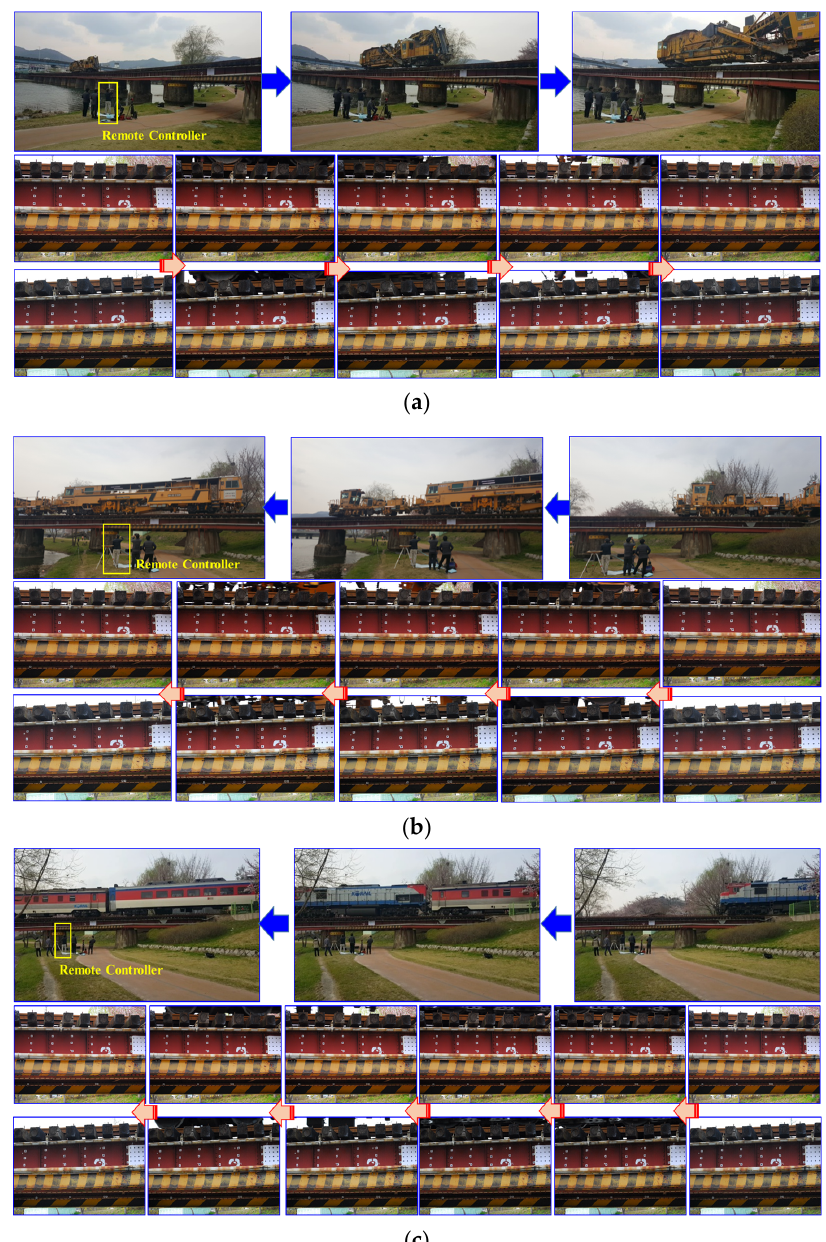
Figure 5. Train entry on the test span of the bridge. ( a ) The first maintenance train captured with five photos in seven seconds; ( b ) the second maintenance train captured with five photos in four seconds; ( c ) the third passenger train captured with six photos in 16 s.